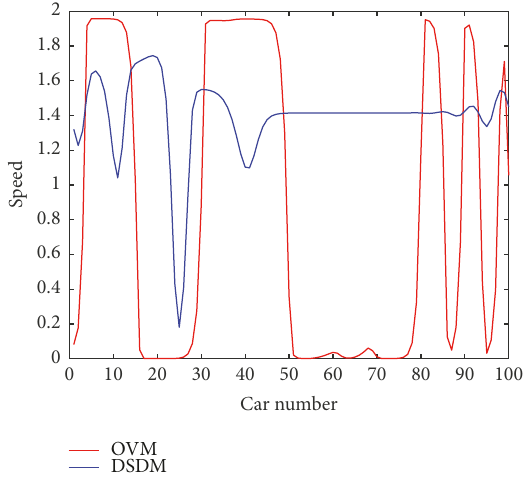
Figure 2: Speed profiles for 𝛼 = 0.5, 𝑇 𝑠 = 1 at 𝑡 = 300s. Figure 3: Speed profiles for 𝛼 = 0.8 , 𝑇